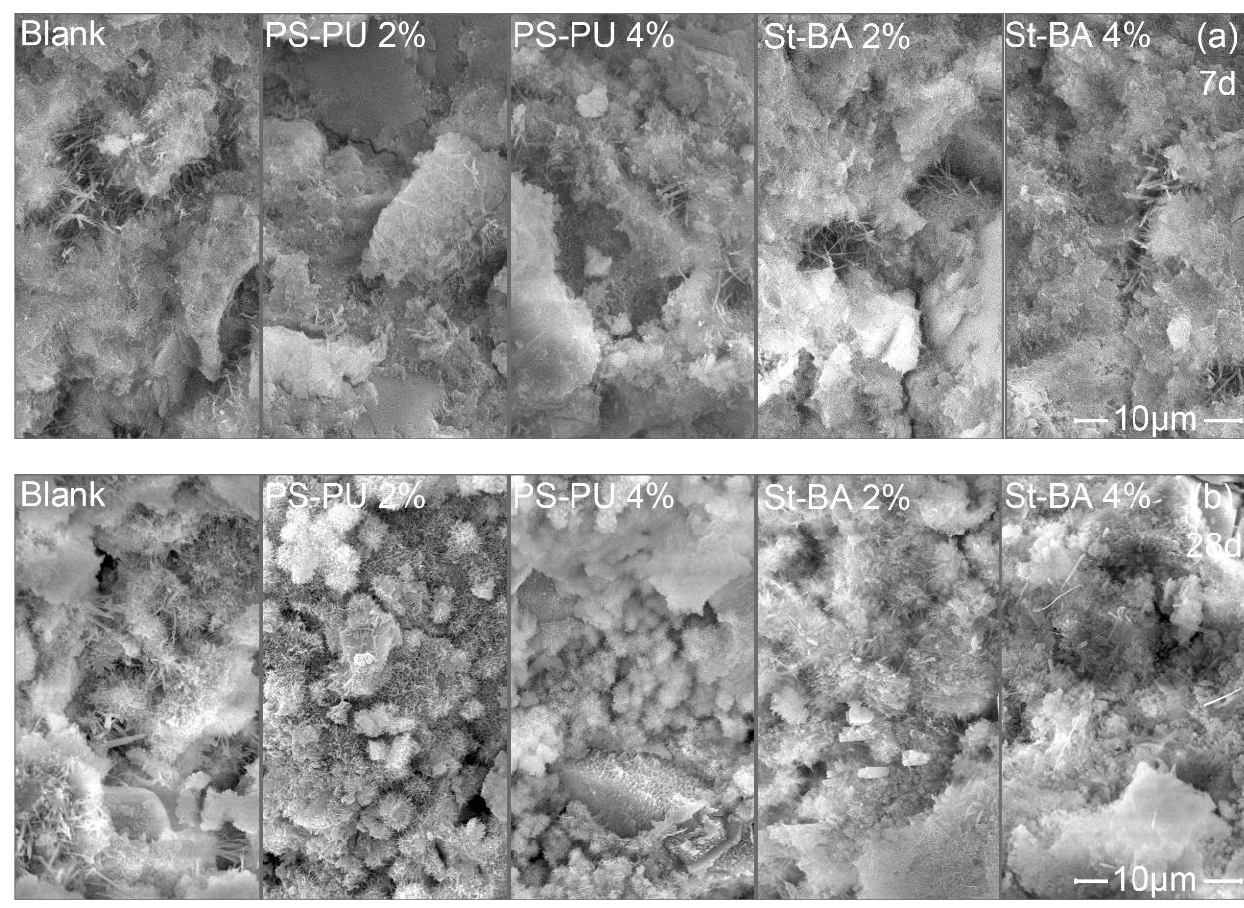
Figure 5. SEM images of hardened paste samples with latex modification: ( a ) 7 d and ( b ) 28 d. The scale bar applies to all the sub-images.